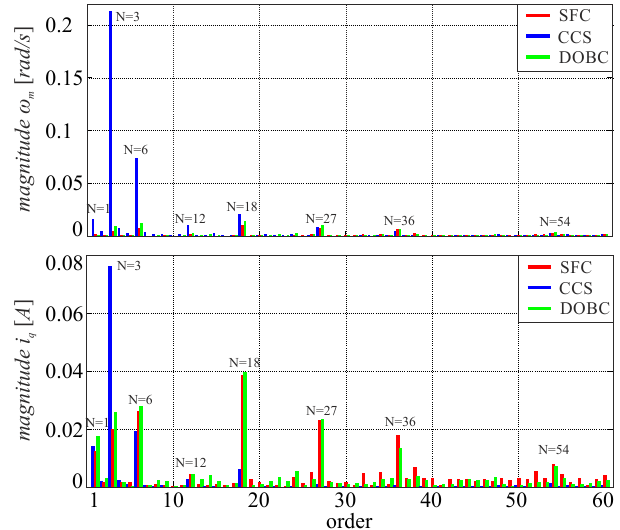
Figure 9. Frequency spectrum of angular velocity and quadrature current component for a set reference of 10